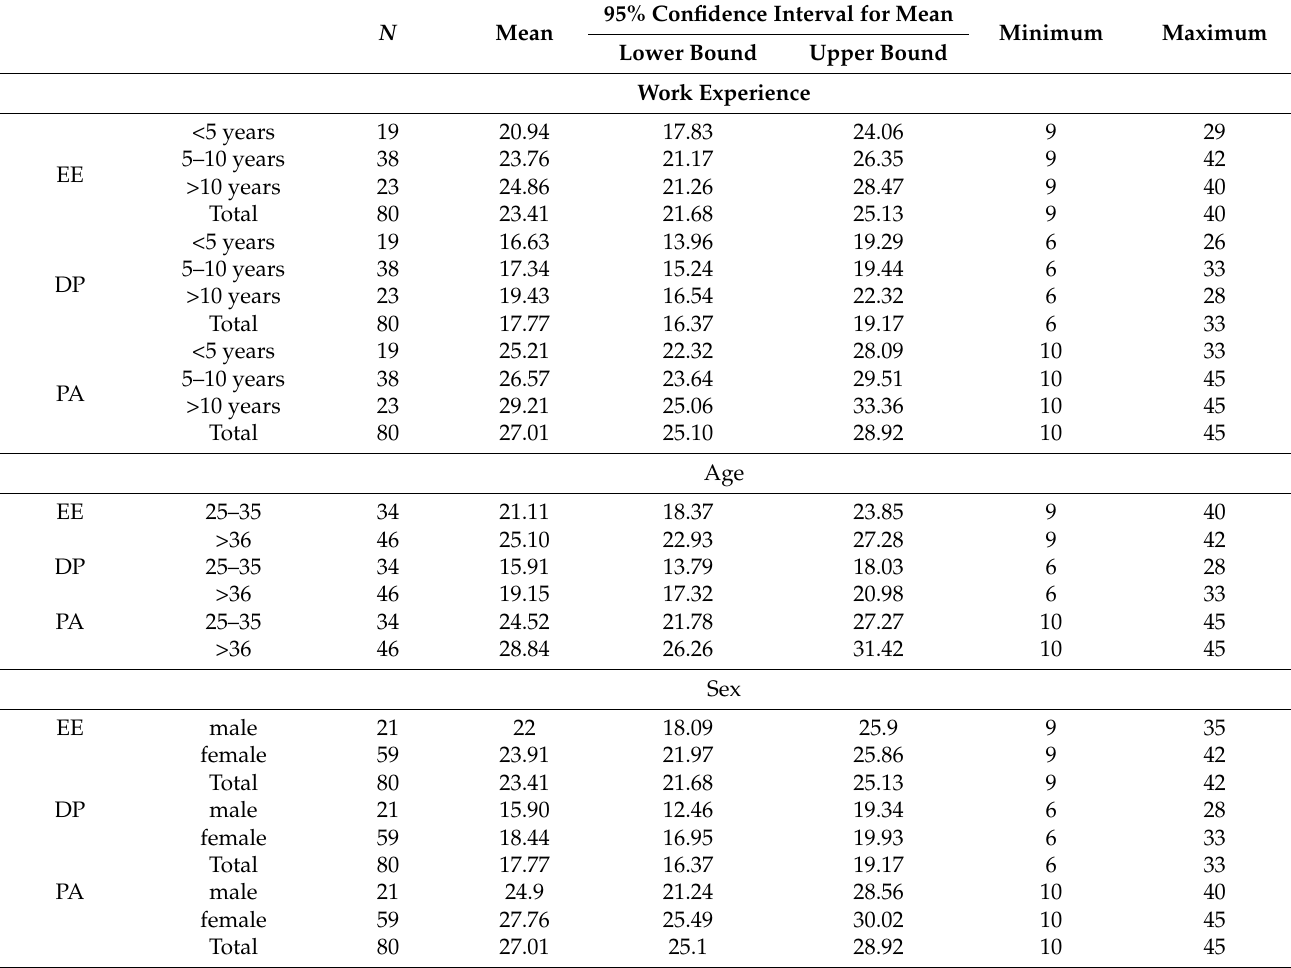
Table 4. Descriptive results of ANOVA testing for variable work experience, age and sex.